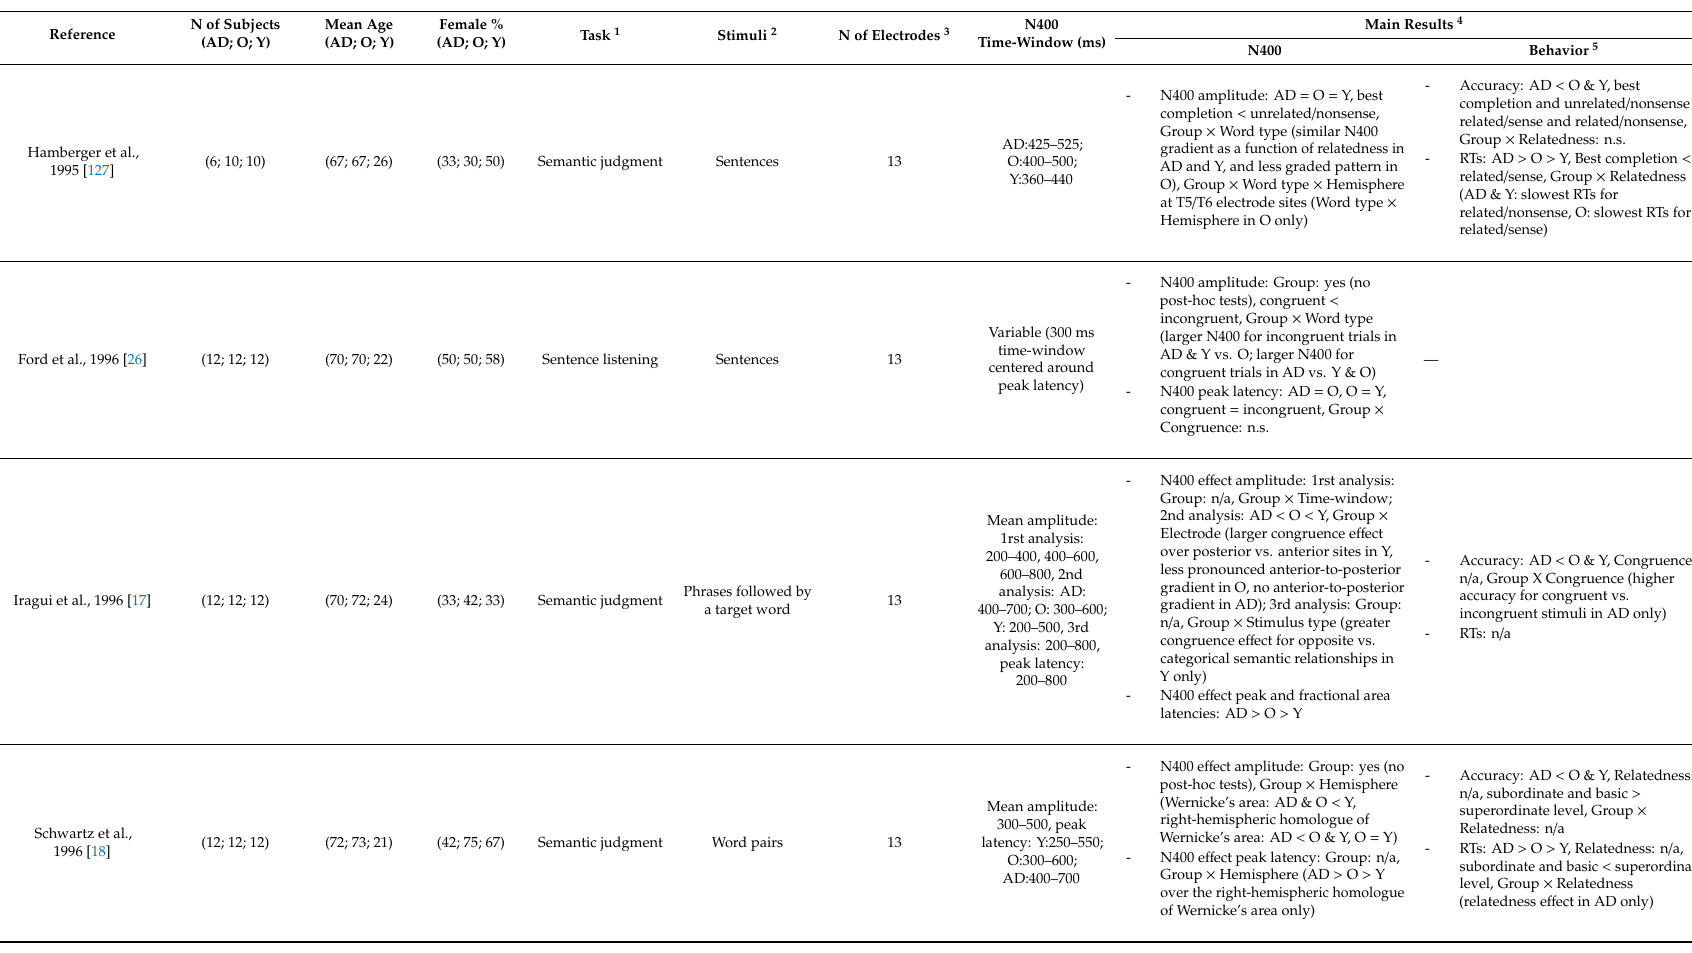
Table A2. Main characteristics of participants, materials and procedures and results of each study including AD participants with control group(s).